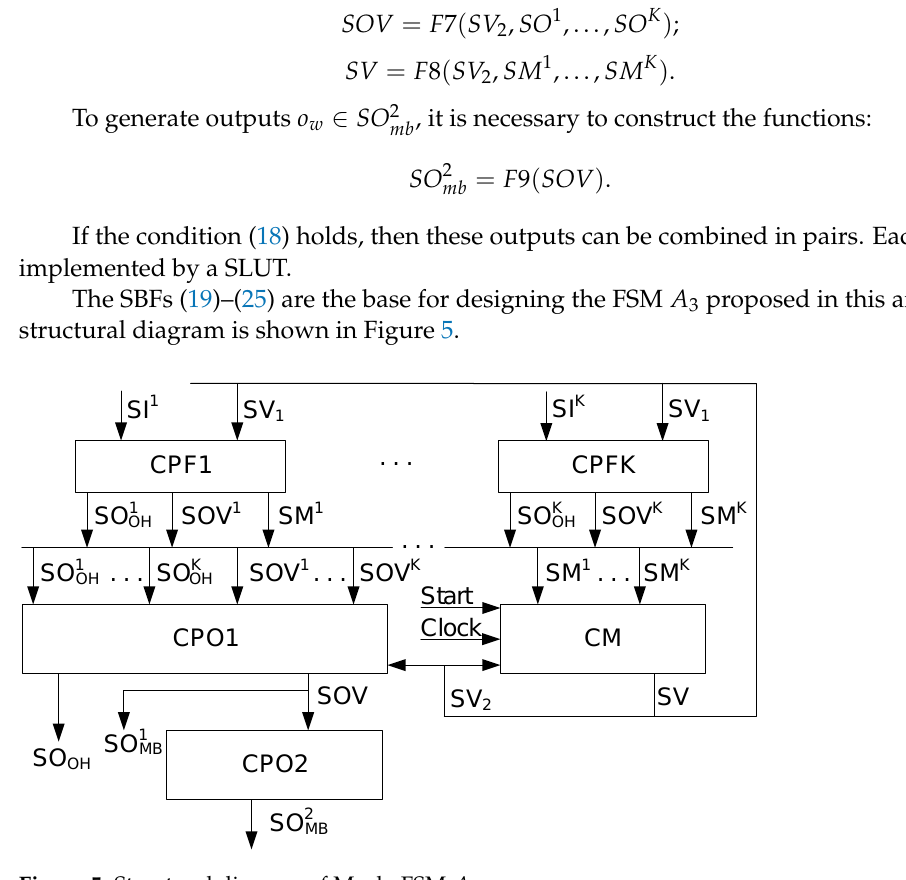
Figure 5. Structural diagram of Mealy FSM A 3